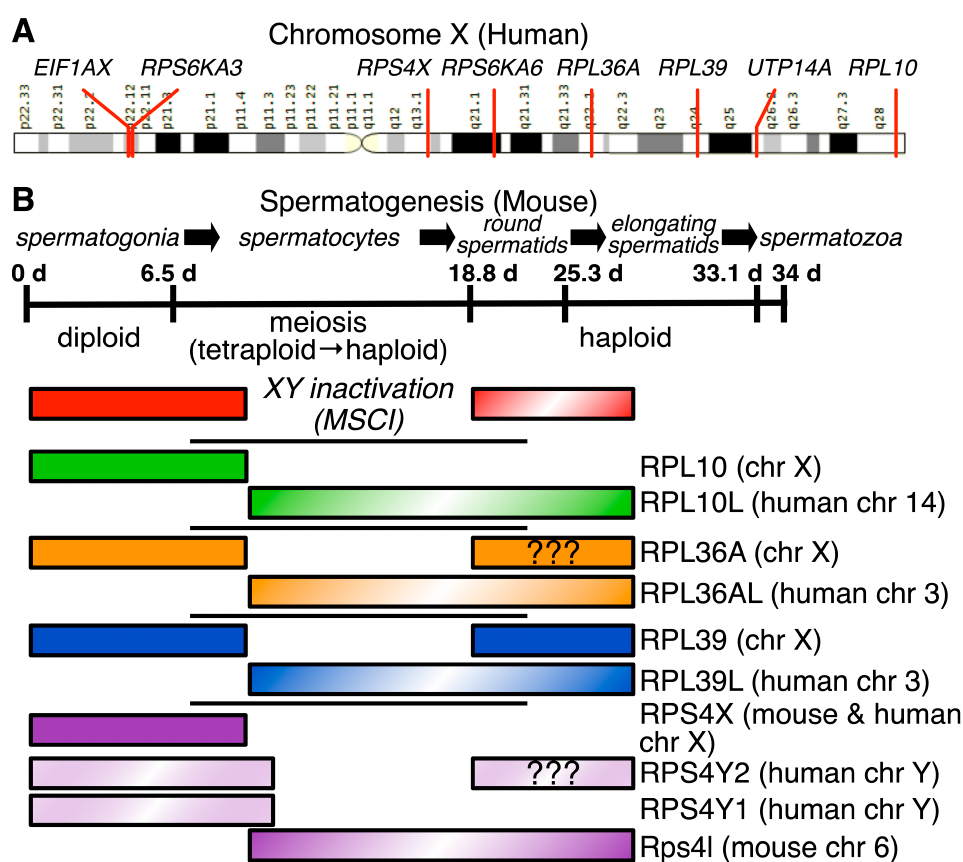
Figure 4. Specialized ribosomal proteins are expressed in male germ cells in mammals. ( A ) Locations of RPs and RP-associated protein genes on the human X chromosome. ( B ) Timeline of mouse spermatogenesis with periods of male sex chromosome inactivation (MSCI) indicated. Times are in days. Colored bars along gene names indicate approximate periods of expression of either the X-linked genes or their homologs in human and mouse male germ cells.